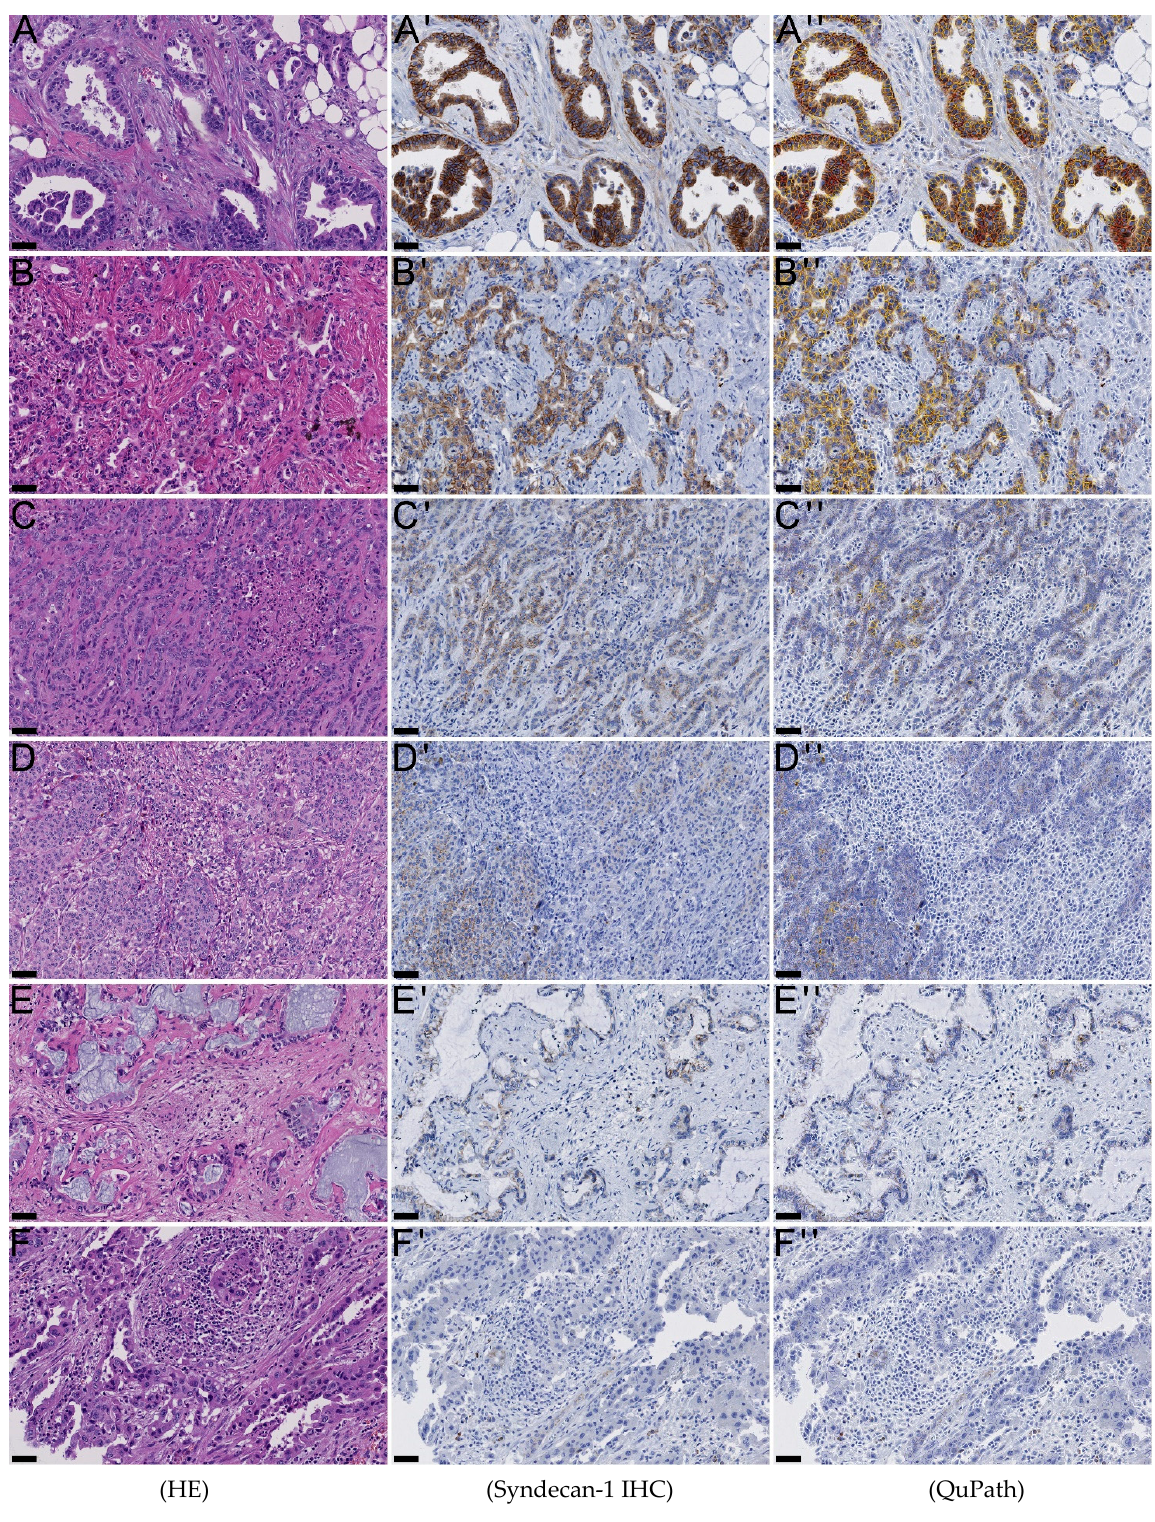
Figure 1. Scoring of syndecan-1 immunohistochemistry: Manual score : Score 3.0 ( A’ ), 2.5 ( B’ ), 2.0 ( C’ ), 1.5 ( D’ ), 1.0 ( E’ ), 0.5 ( F’ ). QuPath H-score 90.00 ( A’’ ), 52.62 ( B’’ ), 1.84 ( C’’ ), 1.02 ( D’’ ), 0.99 ( E’’ ), 0.05 ( F’’ ). Intrahepatic cholangiocarcinoma of small ( C , D ) and large ( A , B , E , F ) duct type are depicted. Classification of tumor staining intensity: red circumference 3+, orange 2+, yellow 1+, blue 0; stroma in white ( A’’ – F’’ ). Black bars: each 50 µm.